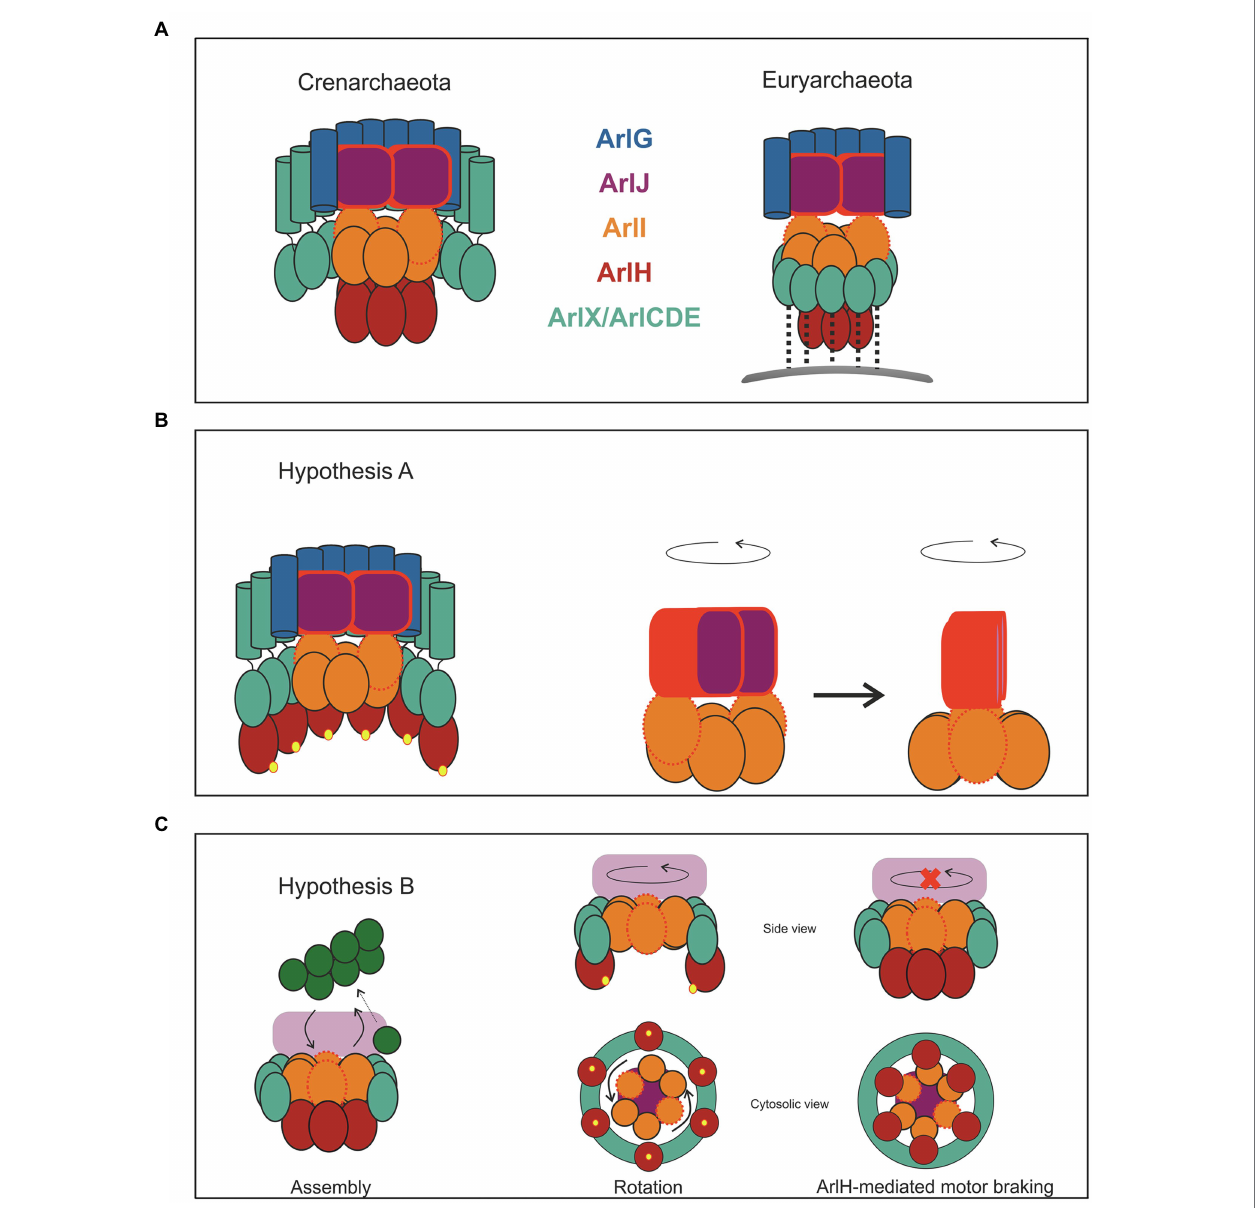
FIGURE 6 | Two hypotheses for archaellum rotation. Despite the differences between the crenarchaeal and euryarchaeal motor, we suggest two hypotheses for the rotary motion of this motor, which are applicable to both phyla. (A) Two schemes representing the crenarchaeal and the euryarchaeal motors. The motor is primed for archaella synthesis when ArlH is interacting with ArlI. Once ArlH is phosphorylated (represented by yellow spheres), this protein is either ejected from the motor complex or remains bound to ArlX or ArlCDE. In (B,C) , only the crenarchaeal motor is shown for simplicity. In hypothesis A, only ArlJ rotates. ArlJ, likely as a dimer, has high affinity for ArlI subunits in open conformation (red, dotted outline) and binds only weakly to ArlI subunits in the closed conformation. ATP hydrolysis causes ArlI subunits to switch from the closed to the open conformation, so sequential ATP hydrolysis causes subunits of closed and open conformation to cyclically go through the otherwise static hexamer. The binding preference of ArlJ to the open conformation of ArlI thus causes ArlJ to rotate by 60 degrees for each ATP hydrolysis step. The rotation of ArlJ thus causes the gyration of the filament. In (B) , both ArlI and ArlJ rotate. The side and bottom views of the motor are shown for clarity. The sequential ATP hydrolysis-induced conformational changes within ArlI push against the ArlX or ArlCDE stators, relax, and push again. The repetition of this process results in ArlI rotation. ArlI tightly interacts with ArlJ, causing it to rotate, which in turn transmits torque to the filament. Through the interaction of ArlH with ArlI (A,B) the conformational changes in ArlI result in piston-like motions in ArlJ, which push archaellins from the membrane into the growing filament. In (B) we show how ArlH may act as a motor brake: when ArlH is dephosphorylated (presumably by an unknown factor), this protein interacts once more with ArlI. Since ArlI, ArlH, and ArlX/CDE form now a triple complex, ArlI is unable to rotate against the ArlX/CDE